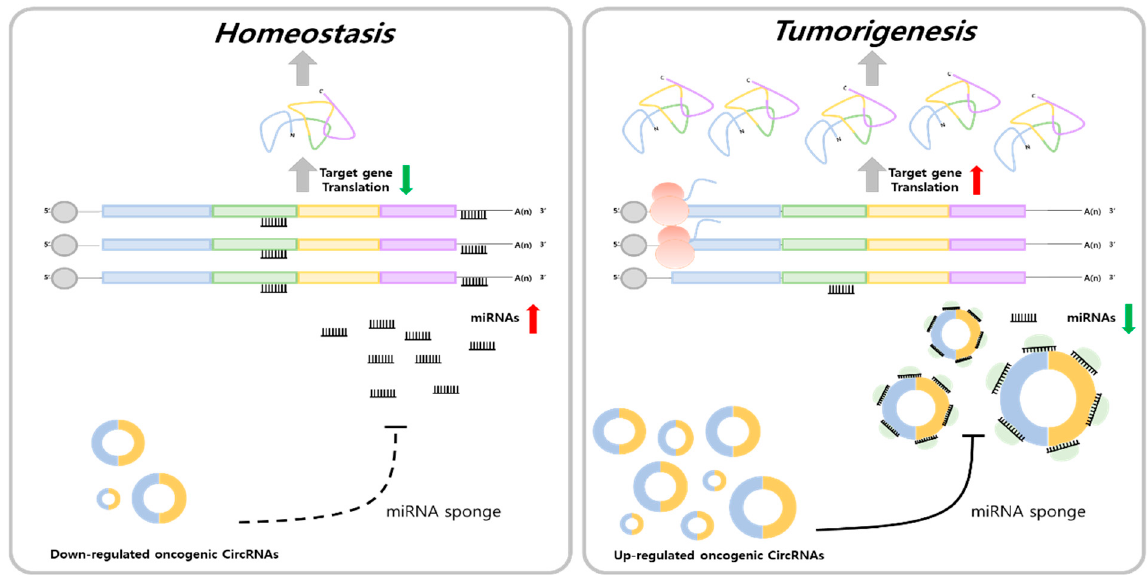
Figure 3. Impact of correlation between oncogenic circular RNA and miRNA in cancer.